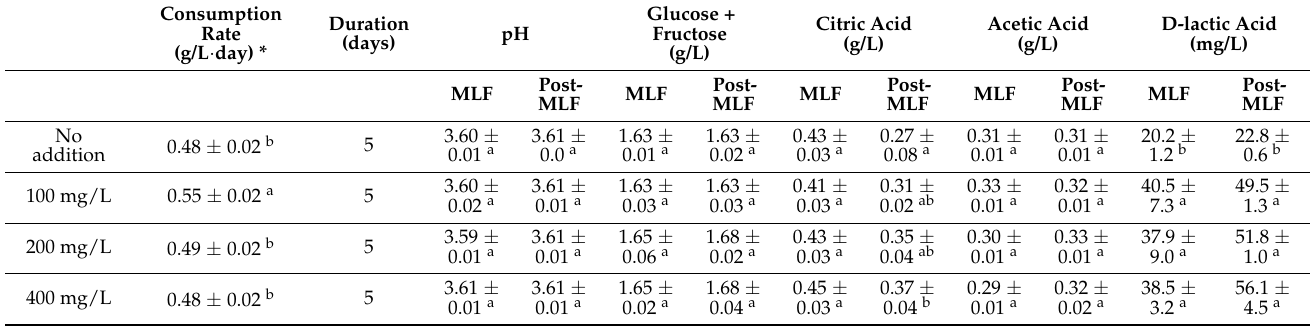
Table 1. Malolactic fermentation (MLF) parameters and concentration of various oenological compounds in wine-like medium. MLF and post-MLF refer to the sampling point at the end of MLF and 3 days of the completion of MLF, respectively.